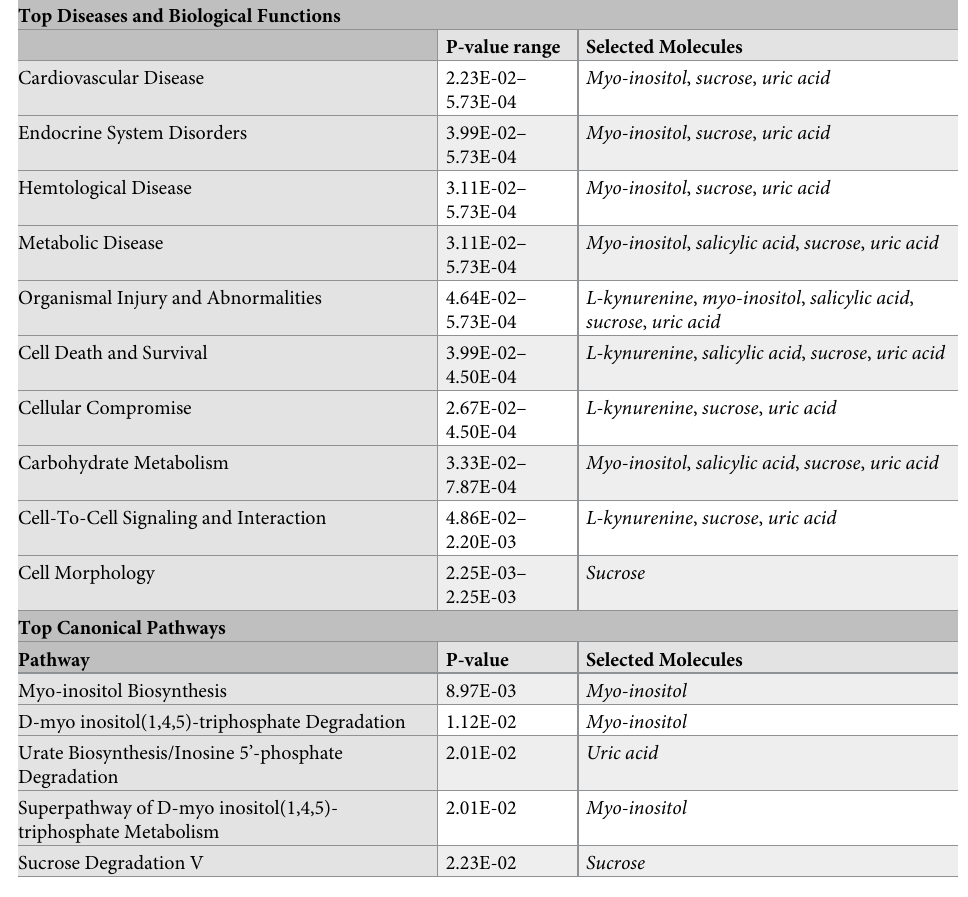
ten biological functions and disease associations.